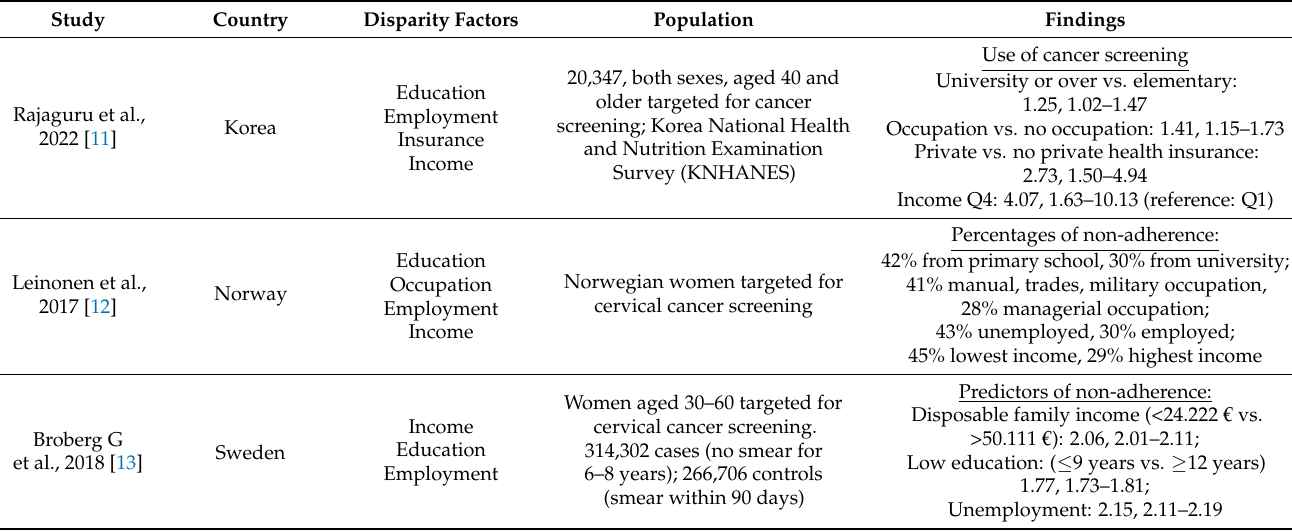
Table 1. Effect of different disparities factors into participation in cancer screening, based on se- lected